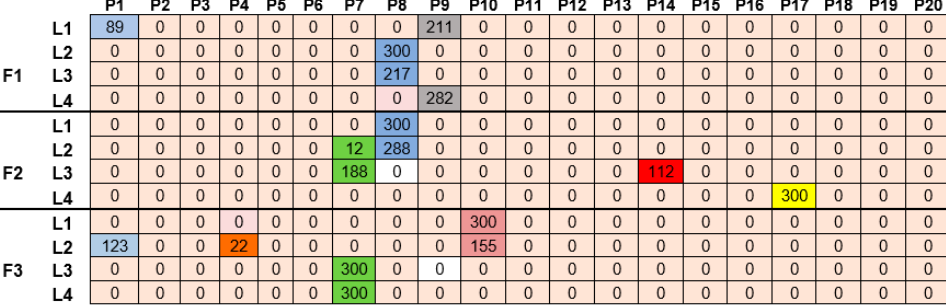
Figure 14. Allocated alternative crop succession to land unit per farm (ha). Table 10. Portion of allocated land use with respect to the available land per farm (ha). Farm Land Available (ha)